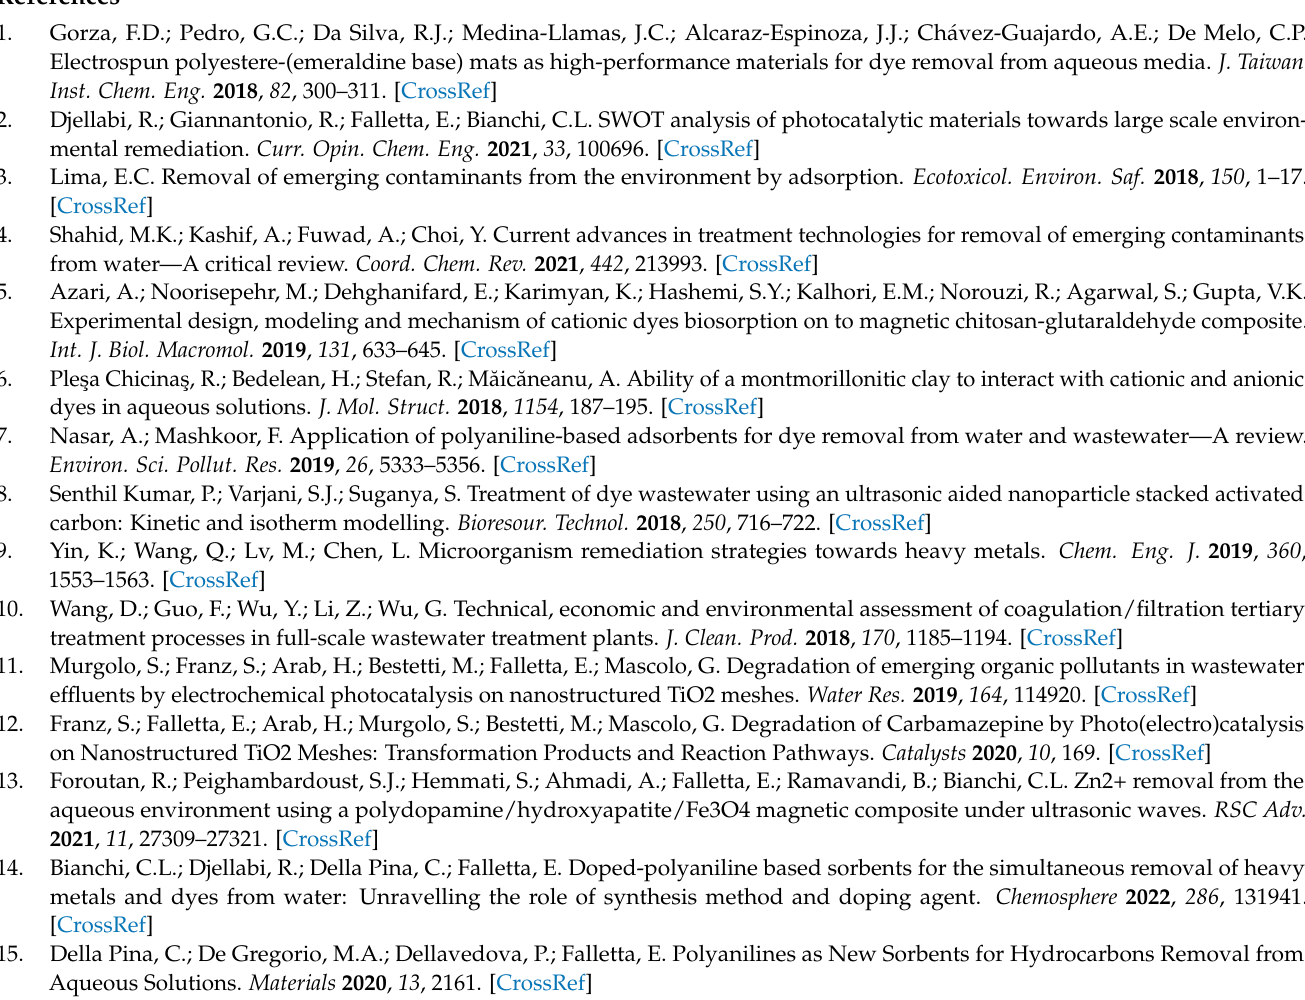
Figure S4: Reuse of PT/PU-2 (up) ad -3 (down) for RHB abatement after washing with